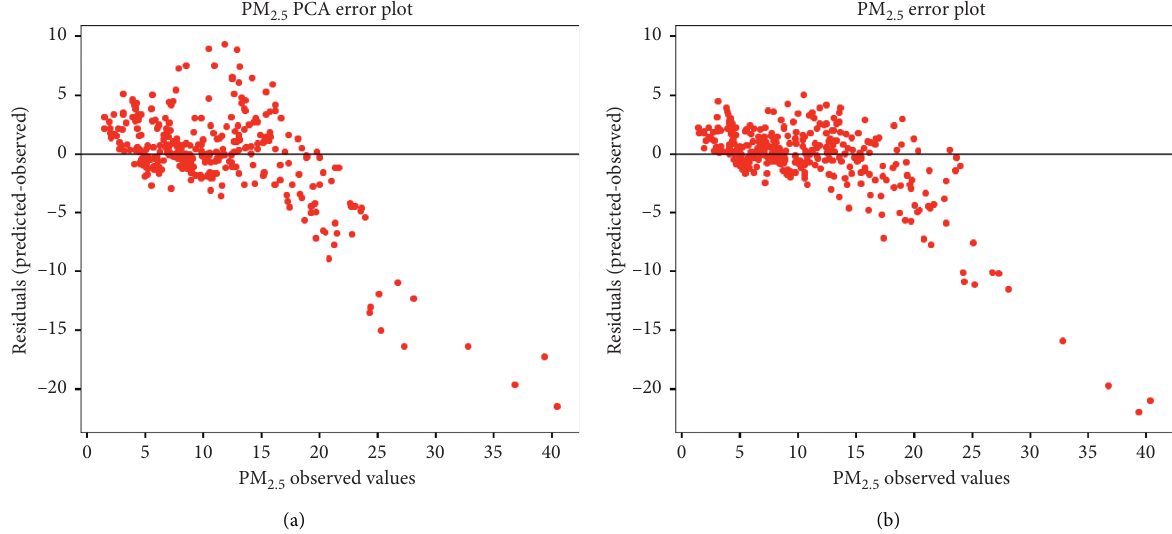
Figure 19: (a) PCA SVR-RBF forecasting errors plotted against observed PM observed PM 2.5 values.